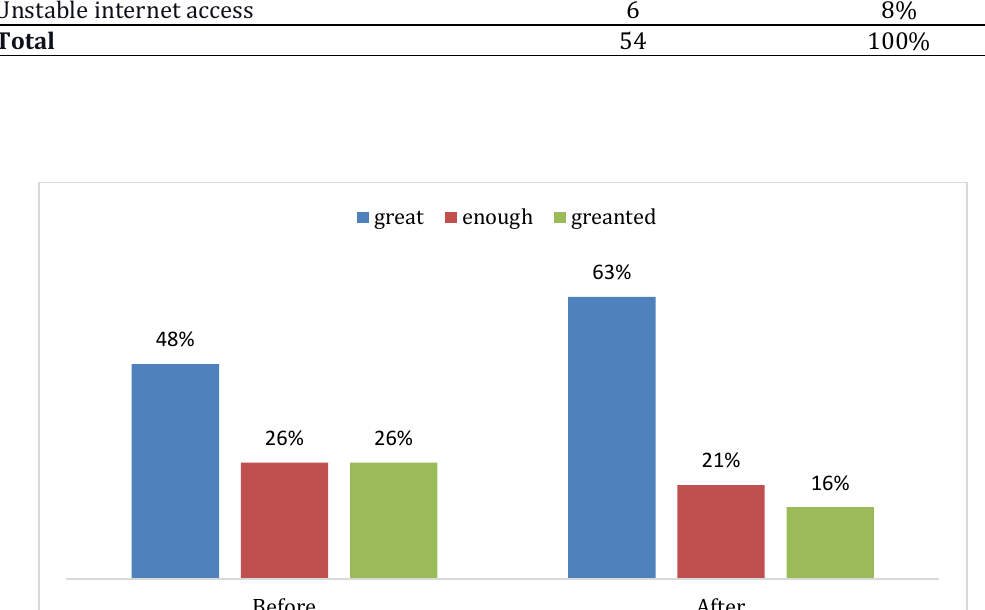
Figure 1. Student Scores in the competency